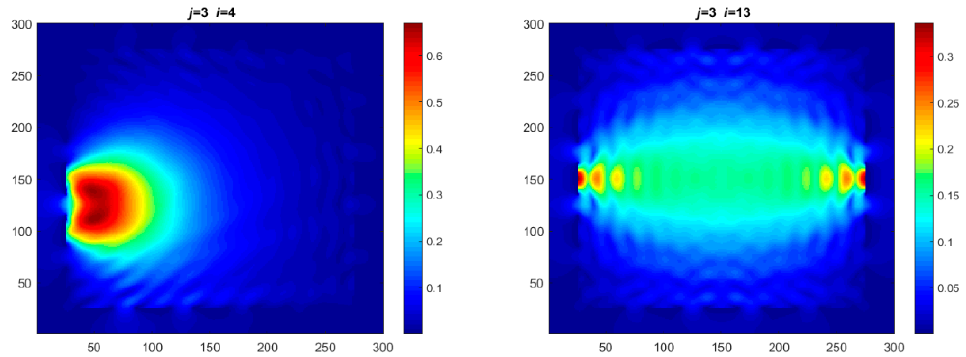
Figure 3. Normalized sensitivity maps of excitation at node, j = 3, with corresponding measurement at node i = 4 and i = 13.